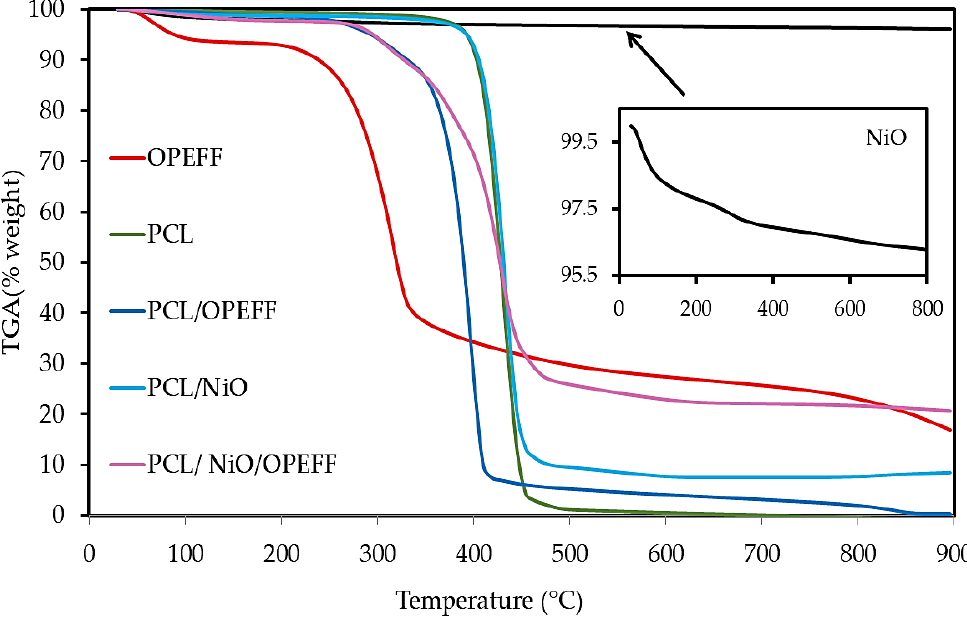
Figure 7. Thermogravimetric analysis (TGA) thermograms of neat PCL, neat OPEFF, neat NiO, PCL/OPEFF, PCL/NiO, PLA/NiO/OPEFF composites.